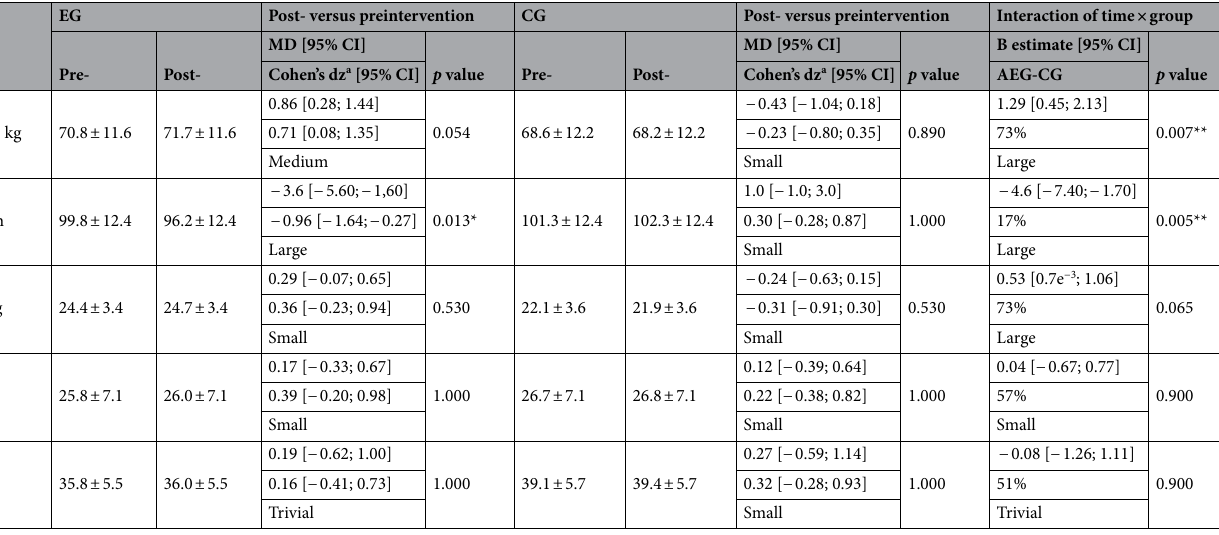
Table 2. Changes in body composition of exercise (EG) and control (CG) groups. Data are estimated marginal means ± standard deviation. a Cohen’s dz are corrected by Hedges g to account for small sample sizes. 95% CI confidence interval at 95%, AEG-CG stochastic superiority of interaction of the time (post- vs. preintervention) and group (EG vs. CG), FM fat mass, MD marginal mean difference, MM muscle mass, Pre- preintervention